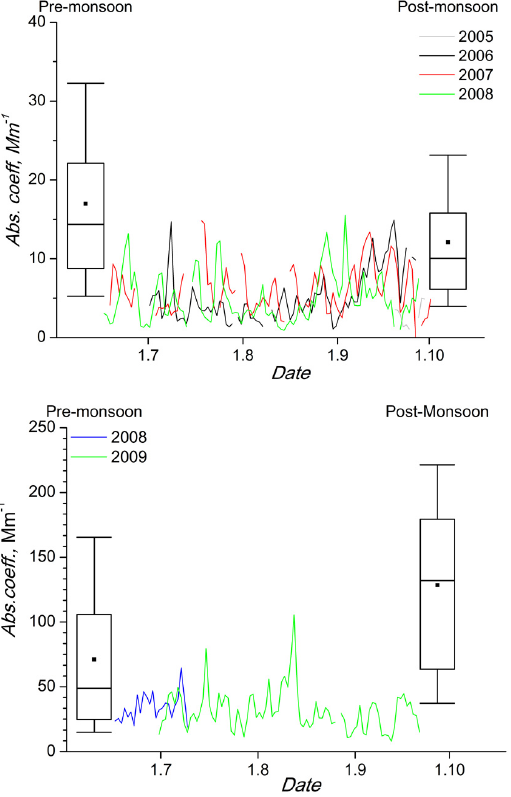
Fig. 6. Scattering coefficient (a) at 525nm in Mukteshwar (b) at 520nm in Gual Pahari. Lines are 24h running averages from the monsoon season, box plots denote to pre- and post-monsoon sea- sonal values of 10%-ile, 25%-ile, median (line), average (dot), 75%-ile and 90%-ile.